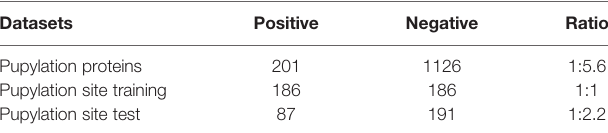
Positive represents the number of positive samples, and Negative represents the number of negative